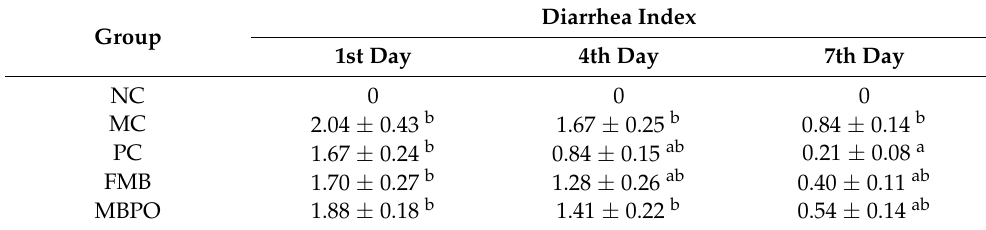
Table 4. Effects of diarrhea in mice.